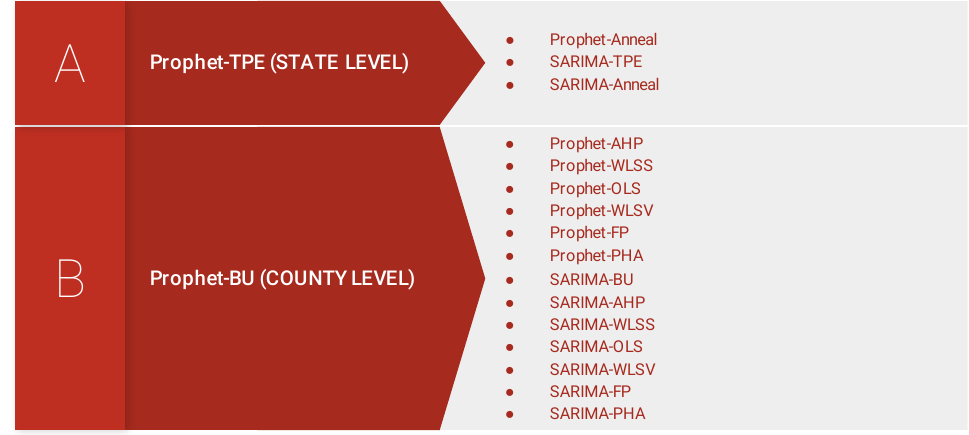
Figure 5. Performance Evaluation of the proposed Prophet-TPE and Prophet-BU models with model combinations of Prophet and SARIMA Bayesian and hierarchical forecasting